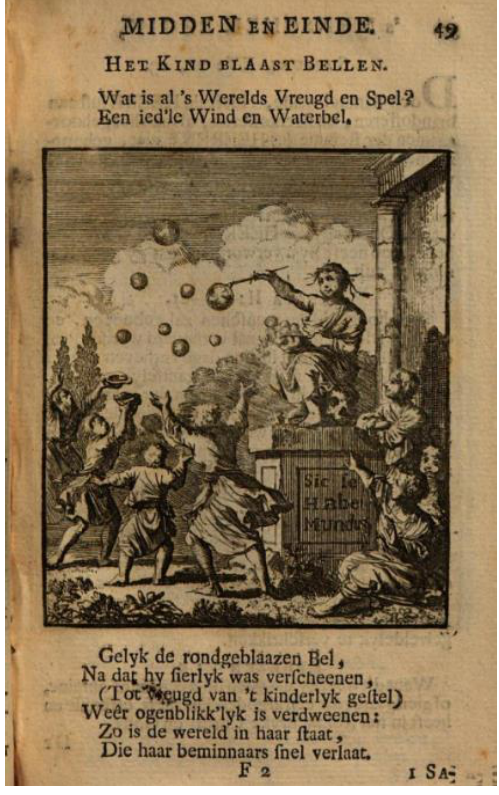
Figure 11. Jan Luyken, “ Het Kind Blaast Bellen .”.